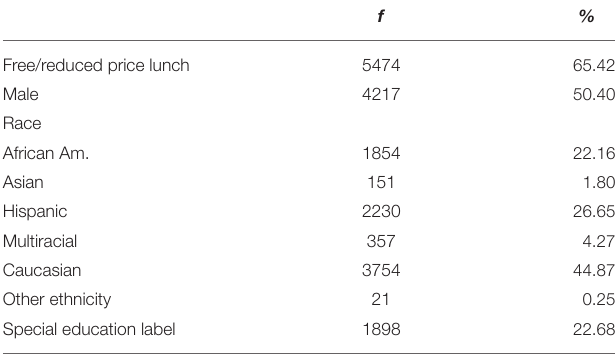
TABLE 1 | Descriptive information ( N = 8367).